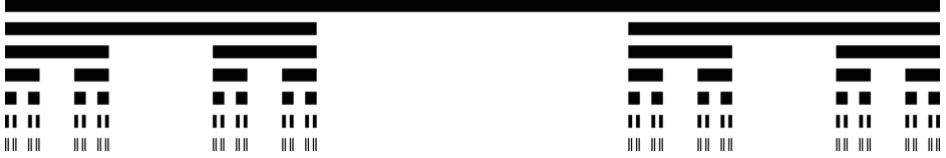
Figure 2. The Cantor Set for six iterations giving ‘fractal dust’ with a fractal dimension of